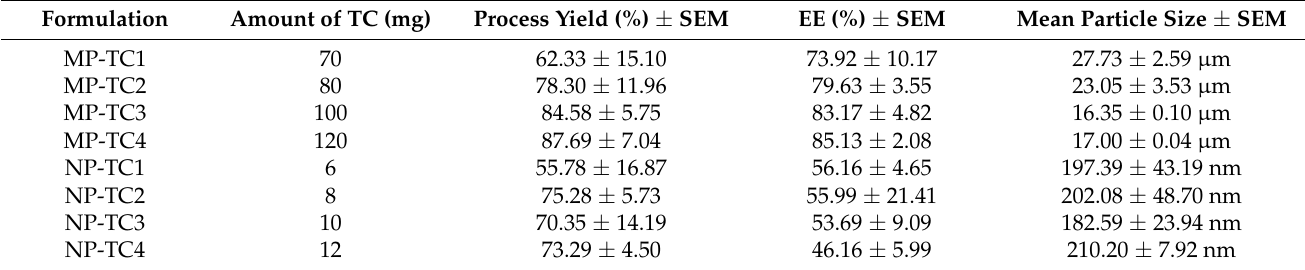
Table 1. Formulations prepared. MP (microparticles). NP (nanoparticles). TC (tolcapone). EE (encapsulation